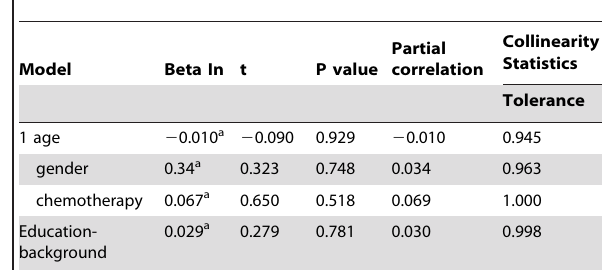
Table 2. Depression and Anxiety in Two Groups.